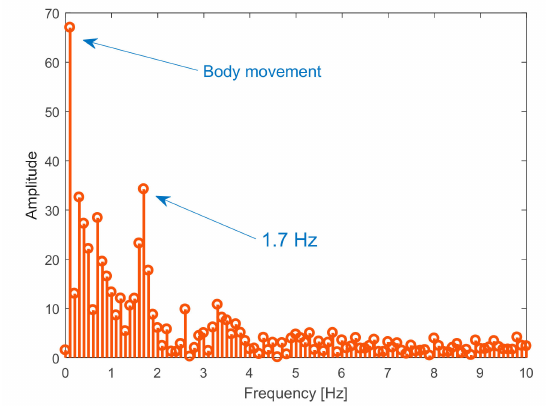
Figure 10. Spectral analysis of detected movement in Figure 9.